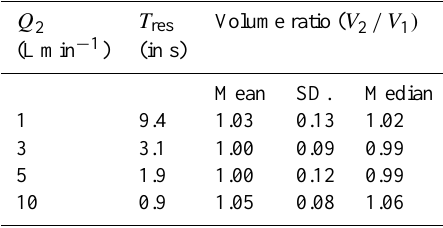
ues of Q 2 . For the nominal flow Q 1 = Q 2 = 3 L min − 1